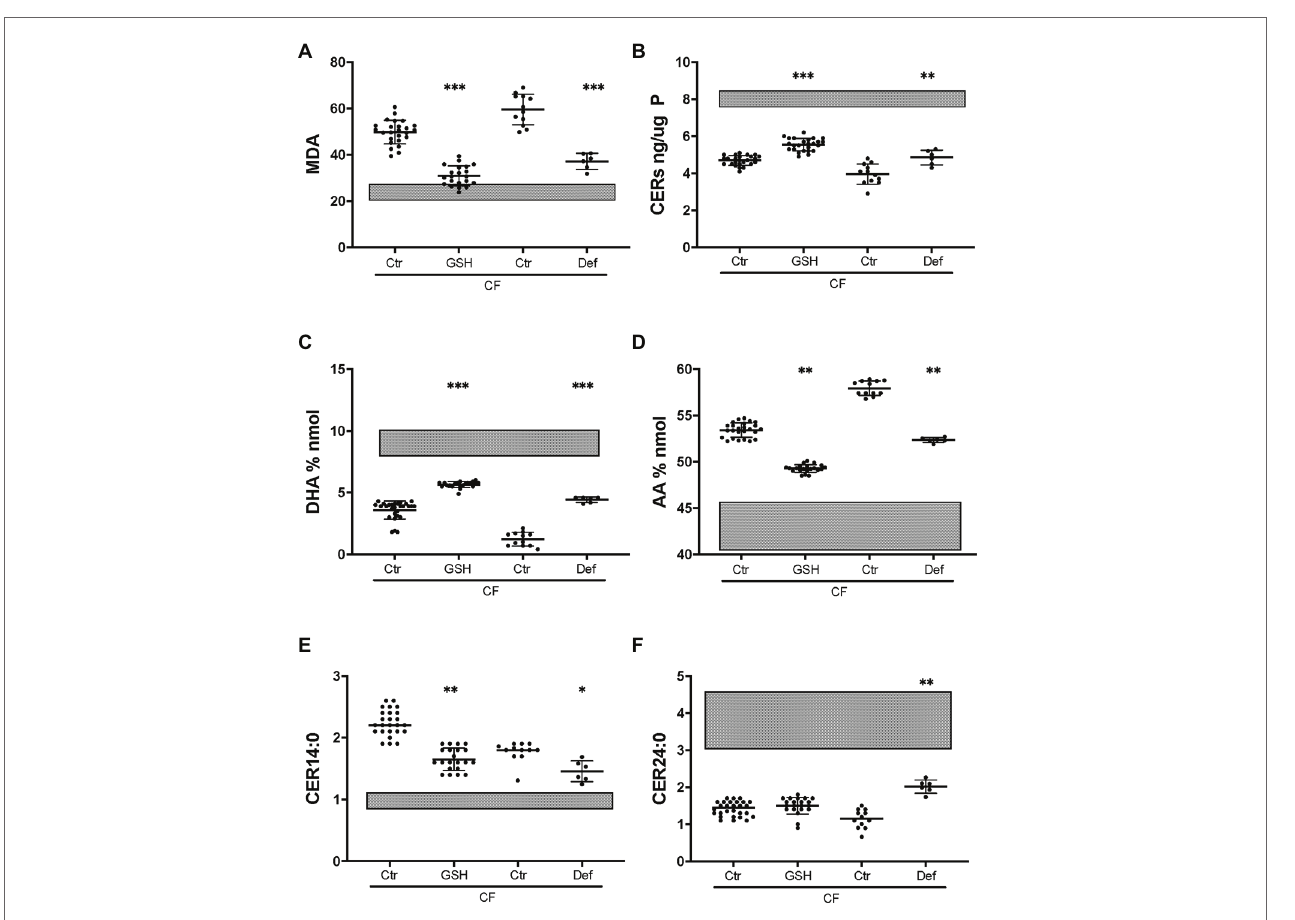
FIGURE 7 | Partial correction of oxidative stress and lipid imbalance by anti-oxidants in CF HBEC-ALI. Treatment of CF HBEC ALI with extracellular glutathione (10 mM GSH, three different donors (BCF000174, N = 15; BCF000554, N = 3; BCF000889. N = 3; N = 21), or deferoxamine (Def, BCF000191 N = 3, BCF000584 N = 3) for 24 h, compared to carrier treated parallel controls of the same donors (Ctr), causes partial correction towards non-CF untreated values indicated as shaded bars representing untreated non-CF average ± SD (five donors analyzed in parallel, Figure 1 ). (A) malondialdehyde (MDA) pmol/nmol fatty acid. (B) Total ceramides. (C) DHA levels (% nmol total fatty acids). (D) AA levels (% nmol total fatty acids). (E) Long-chain ceramide (CER14:0). (F) Very long-chain ceramide (CER24:0) both expressed as pmol/nmol phosphate. Most relevant comparisons are indicated (unpaired one-way ANOVA, Dunnet, * p < 0.05, ** p < 0.01, *** p <